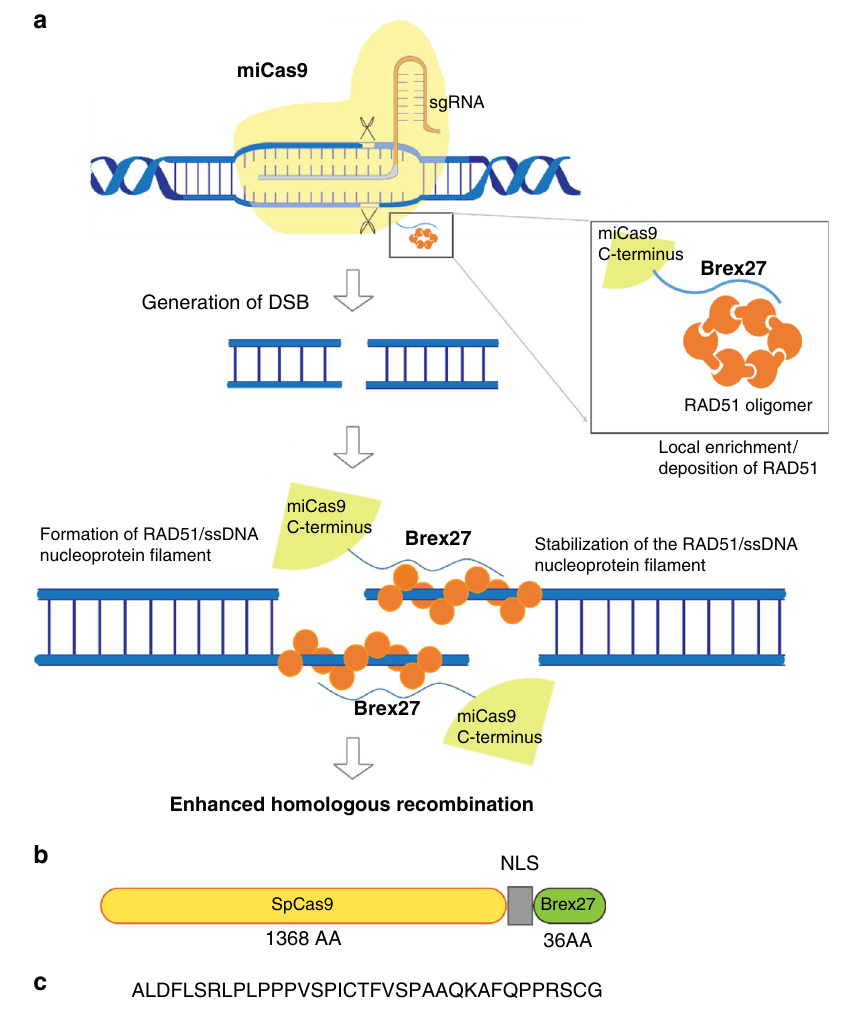
Fig. 1 Illustration of miCas9 design. a Rationale for miCas9 design. b Illustration of miCas9-expressing plasmid DNA construct. c Amino acid sequence of the Brex27